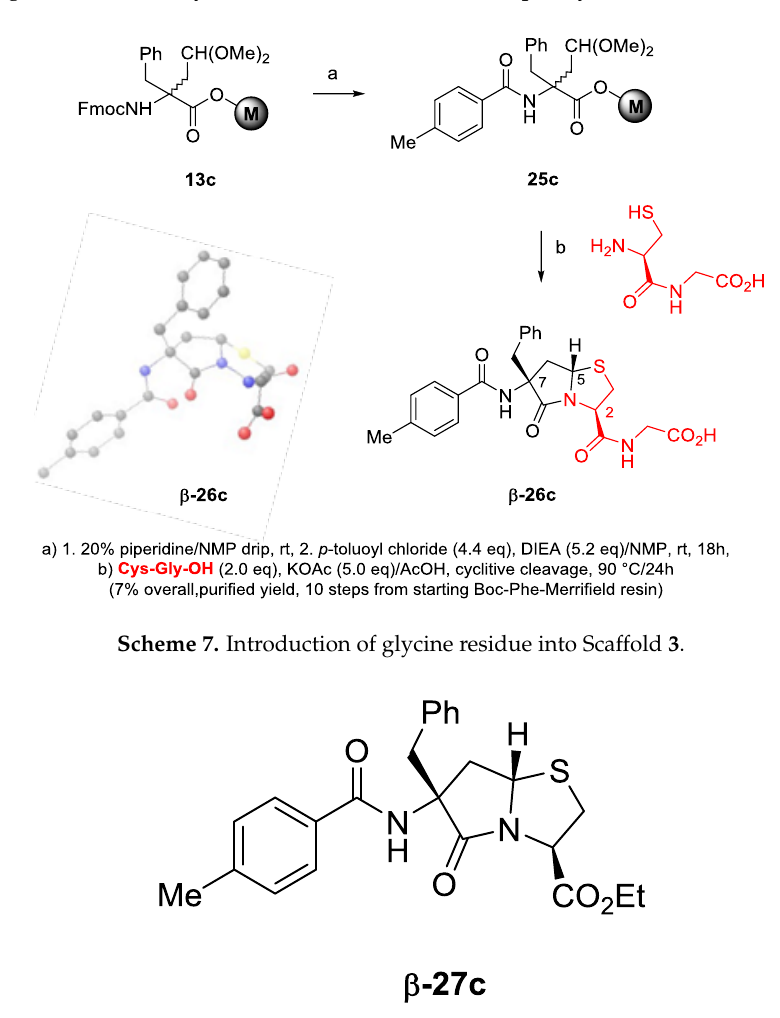
Figure 1. Previously established stereochemistry of β - 27c .